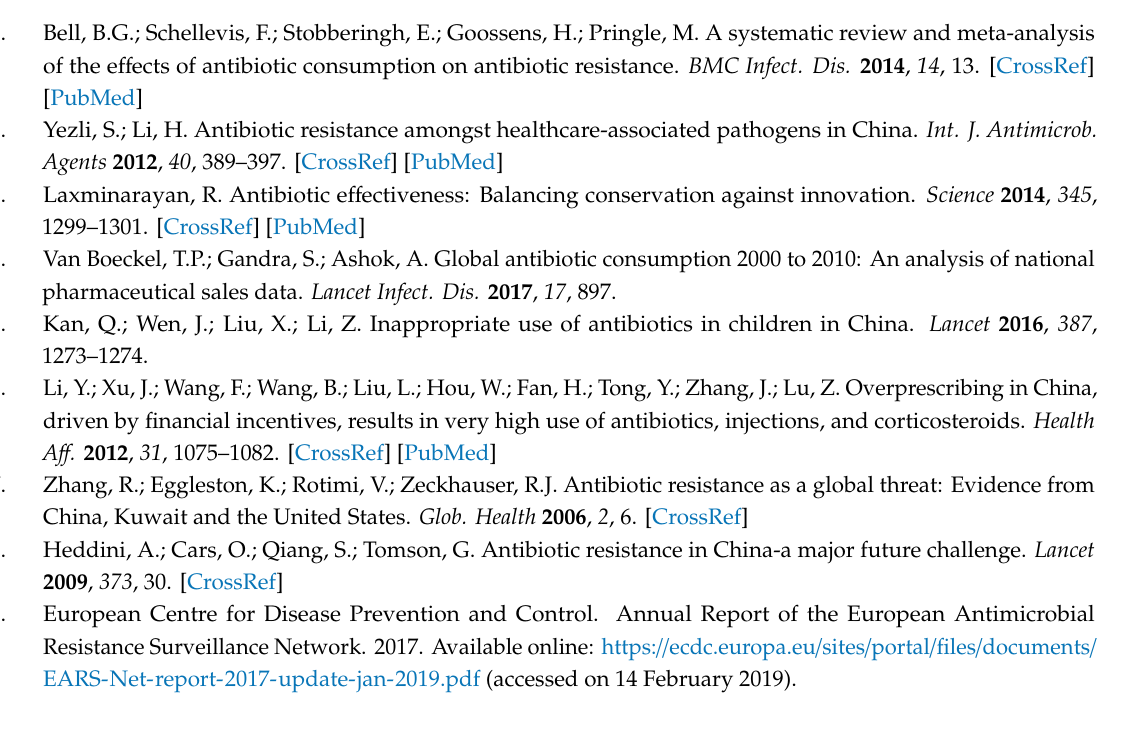
Table S2: Studies describing hospital stay among patients with antibiotic resistance and multi-drug resistance, Table S3: Studies describing hospital costs among patients with antibiotic resistance and multi-drug resistance; Supplementary data 3: Study quality assessment: Table S4: Quality assessment checklist for nonrandomized studies, Table S5. Study quality of the included